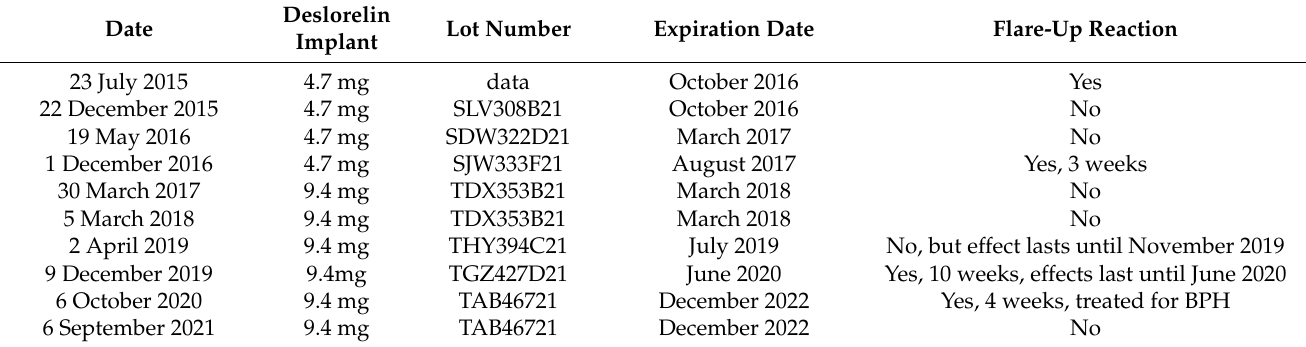
Table 2. Date of implantation, type of deslorelin implant, lot number, expiration date and presence of a flare-up reaction following treatment of an American Staffordshire intact male dog continuously treated with deslorelin between 2015 and 2021. A flare-up reaction occurred in December 2016 as the dog was reimplanted after more than 6 months following the previous 4.7 mg